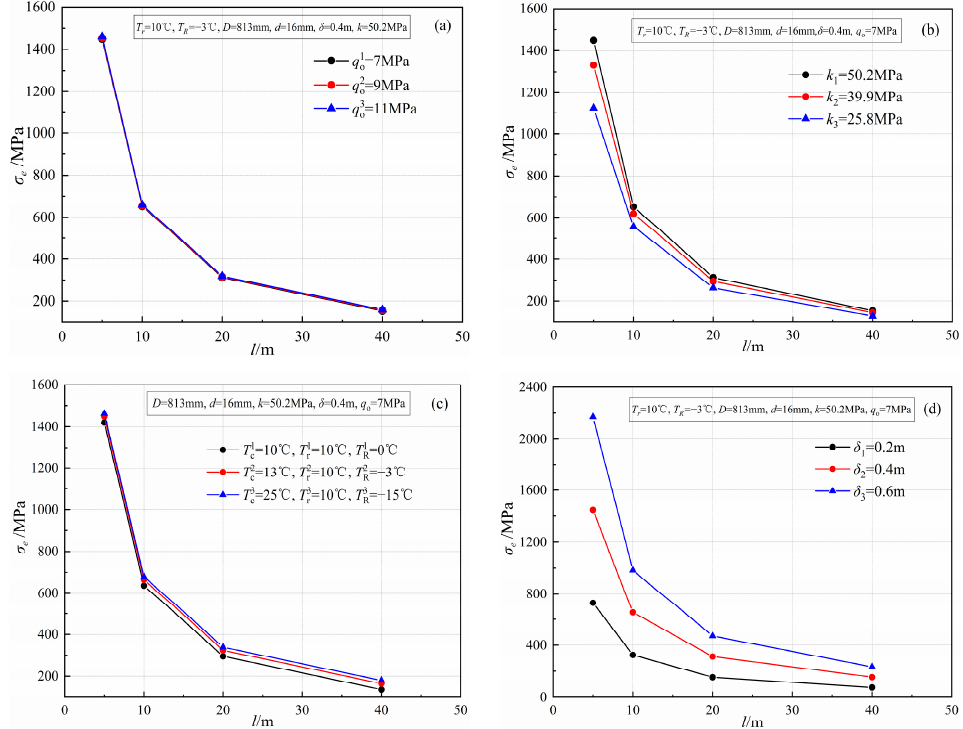
Figure 9. Variations in the equivalent stresses with the length of the transition region. ( a ) Under different oil pressures; ( b ) Under different foundation coefficients; ( c ) Under different temperature differences; ( d ) Under different frost heaves.